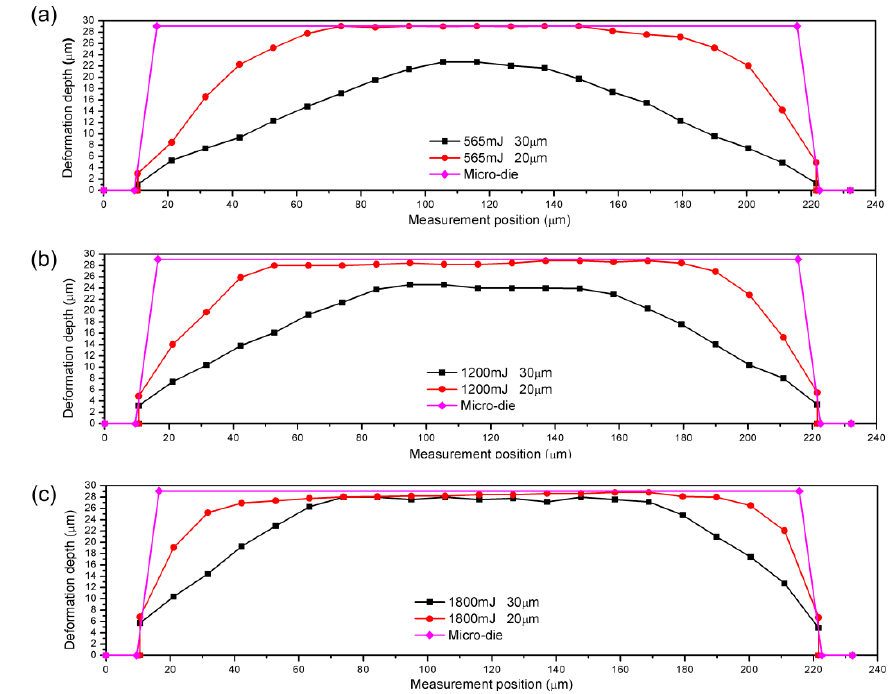
Figure 14. Sectional curves of the formed parts with the thickness of 20 μ m and 30 μ m under different laser energy: ( a ) under the laser energy of 565 mJ, ( b ) under the laser energy of 1200 mJ, and ( c ) under the laser energy of 1800 mJ.